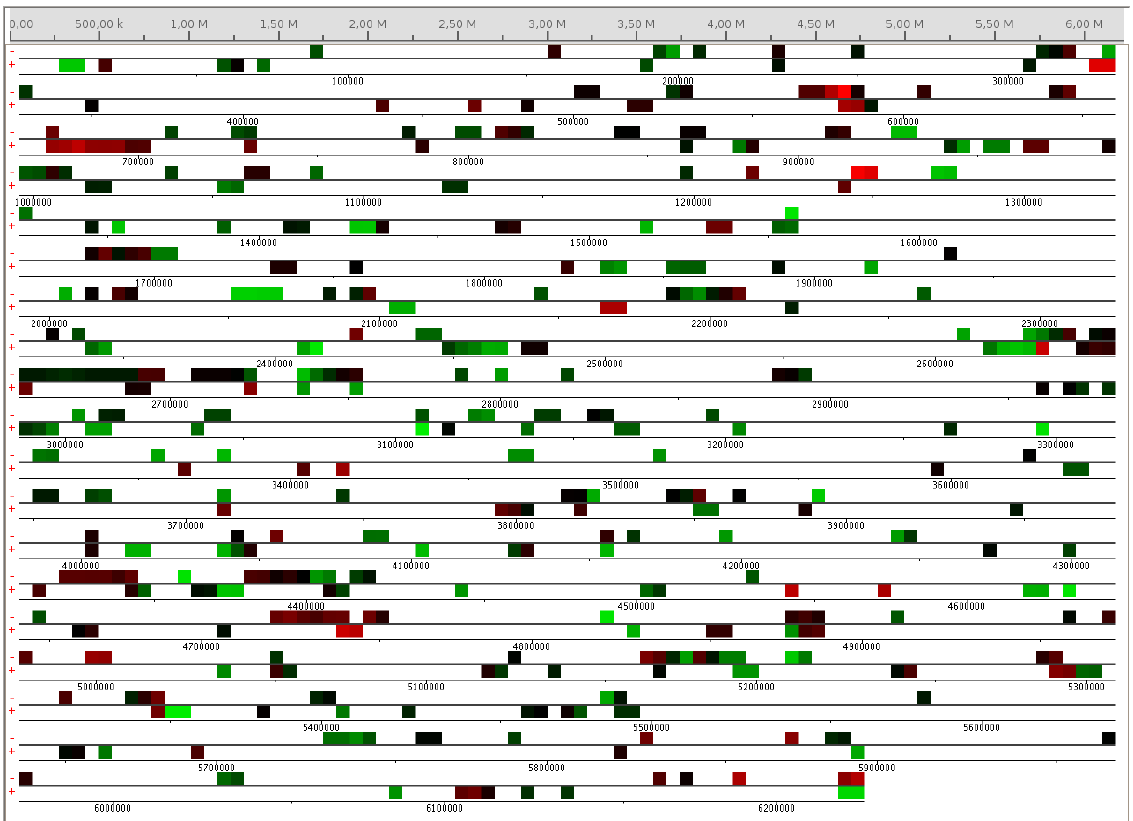
Figure 1: Genome Heat stream visualization of highly variant genes in Pseudomonas aeruginosa (variance across all experiments > 0 . 5